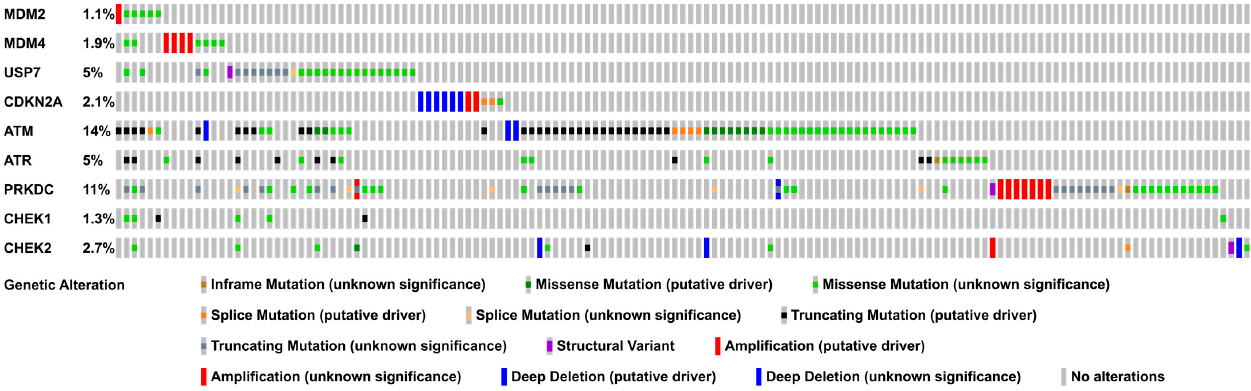
Figure 6. Prevalence of genetic alterations in upstream p53 regulators in COAD. The Oncoprint displays the genomic alterations (legend) in upstream p53 regulators (rows) across 526 COAD samples (columns; TCGA, PanCancer COAD dataset). For the sake of simplicity, only the 143 samples with genetic alterations are displayed. The full Oncoprint including all samples is shown in Supplementary Figure S1. The data were accessed via the cBioPortal webservice (https://www.cbioportal.org/) [131,132].